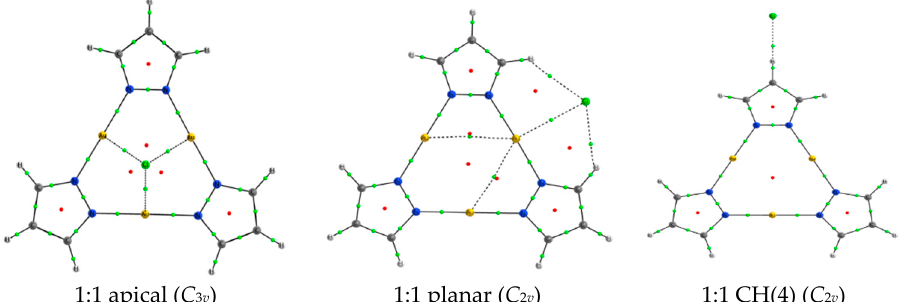
Figure 4. Molecular graph of the three minima located for the 1:1 (Pz-Au) 3 : Cl – . The symmetry of each complex is indicated. Small green and red dots indicate the position of the bond and ring critical points, respectively.